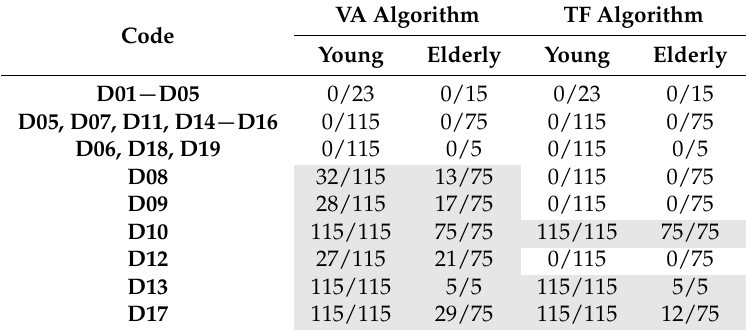
Table 4. Number of false positives that occurred during ADLs.